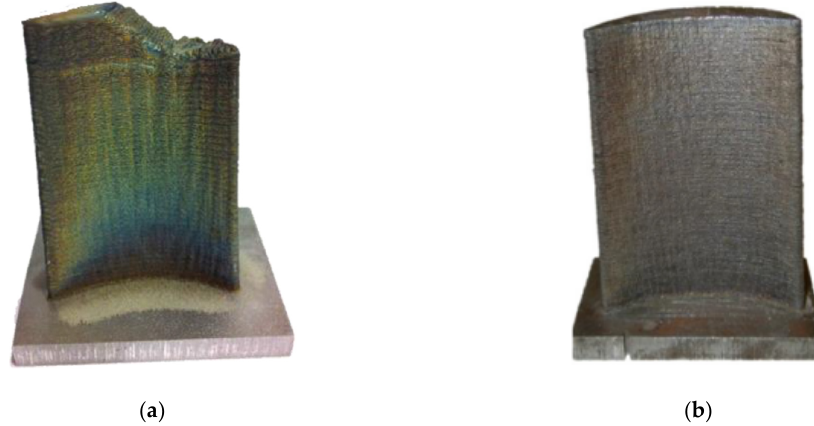
Figure 7 .(a) Damaged tip and (b) reconstructed tip reproduced with permission from Wilson et.al [64], Figure 7. ( a ) Damaged tip and ( b ) reconstructed tip reproduced with permission from Wilson et.al [64], Journal of Cleaner Production; published by Elsevier, 2014. Journal of Cleaner Production; published by Elsevier,